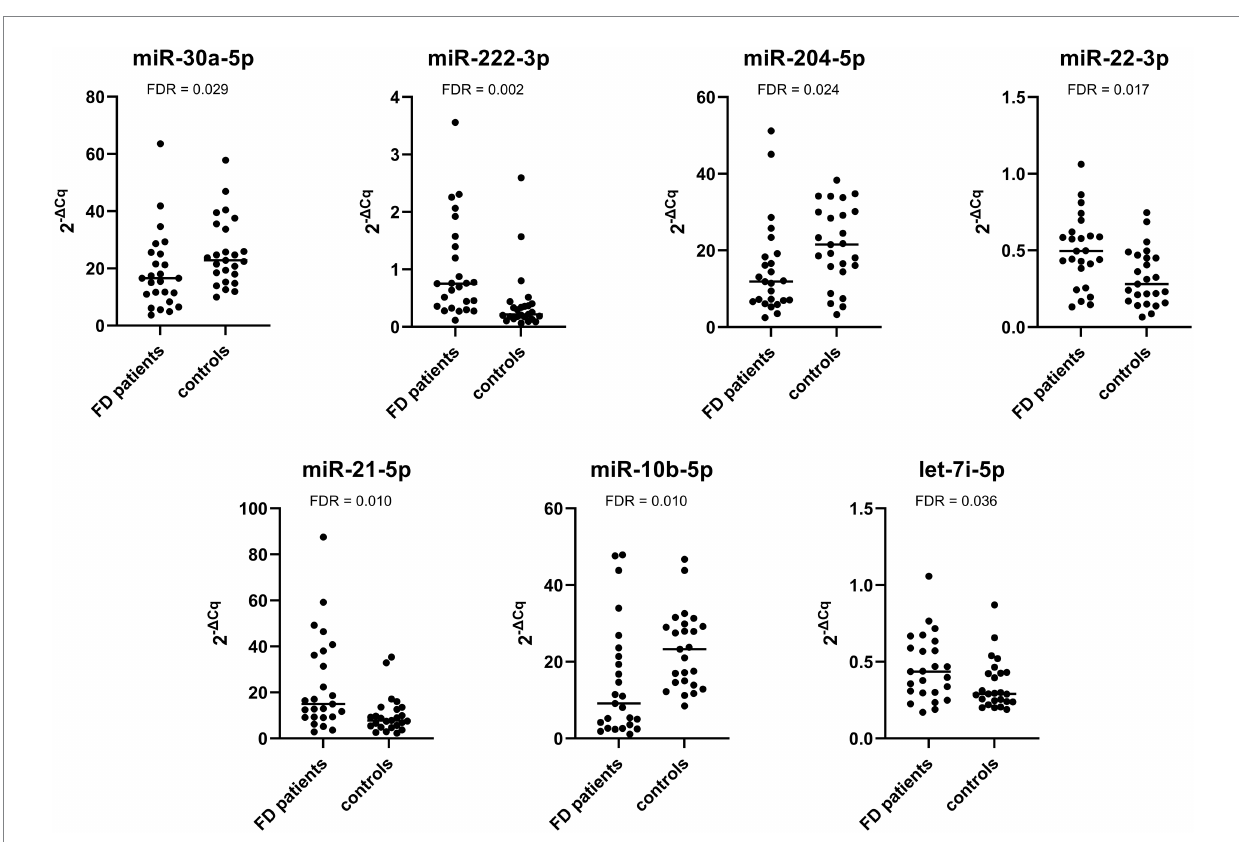
FIGURE 2 Relative expression of selected miRNAs in the validation cohort composed of Fabry patients with stable renal function and their matched